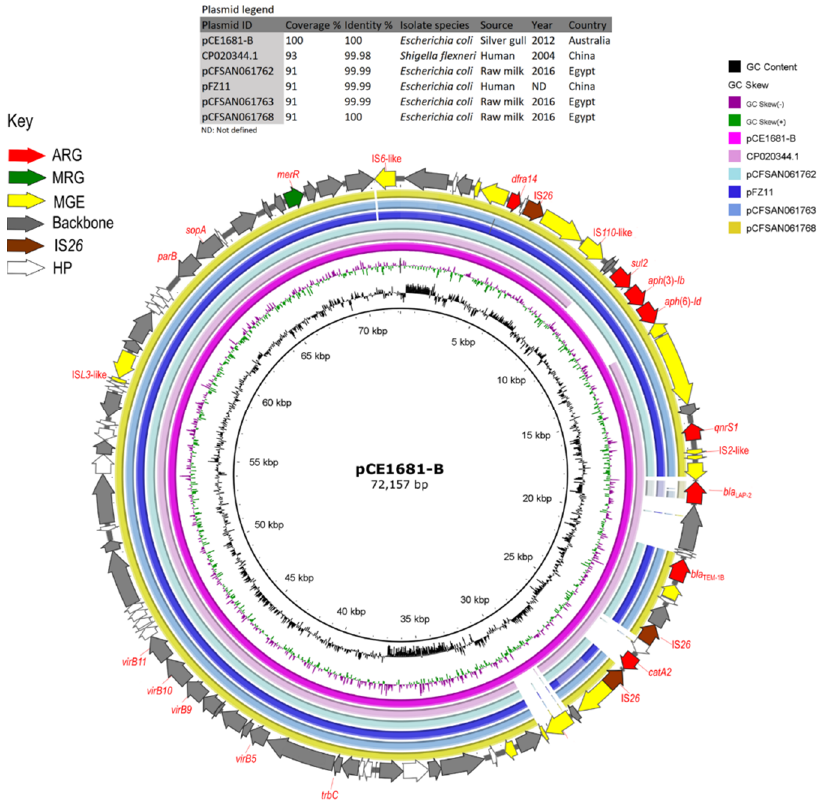
Figure 6. BRIG comparison of qnrS1 positive IncFIB(K) plasmid pCE681-B with similar plasmid sequences retrieved from GenBank. In the key, ARG: antibiotic-resistance gene, MRG: metal resistance gene, MGE: mobile genetic element and HP: hypothetical